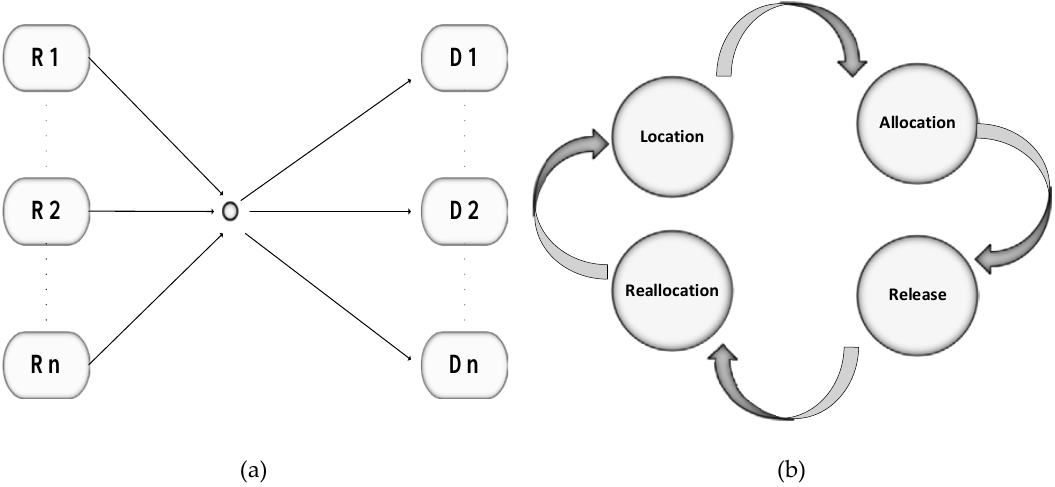
Figure 2. General Resource Allocation Process ( a ) Overall Resource Allocation Cycle with release and reallocation ( b ). reallocation ( b